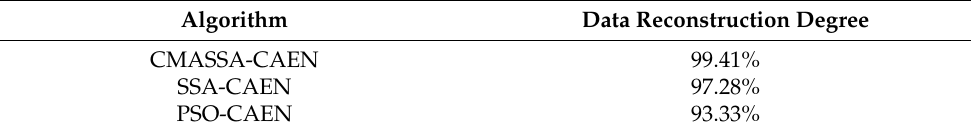
Table 10. The data reconstruction degree of the optimization algorithm on the